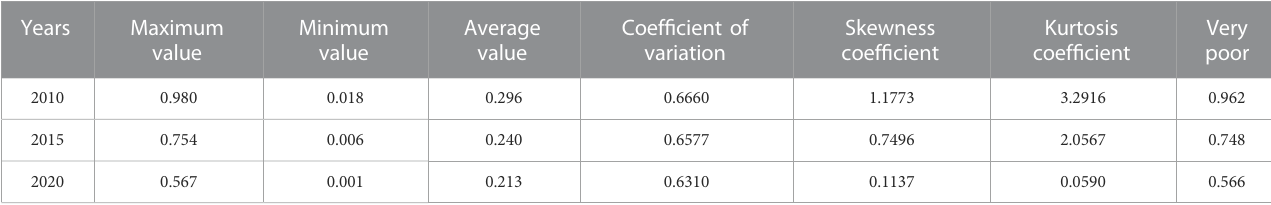
TABLE 5 Descriptive statistical indicators of urban comprehensive resilience.